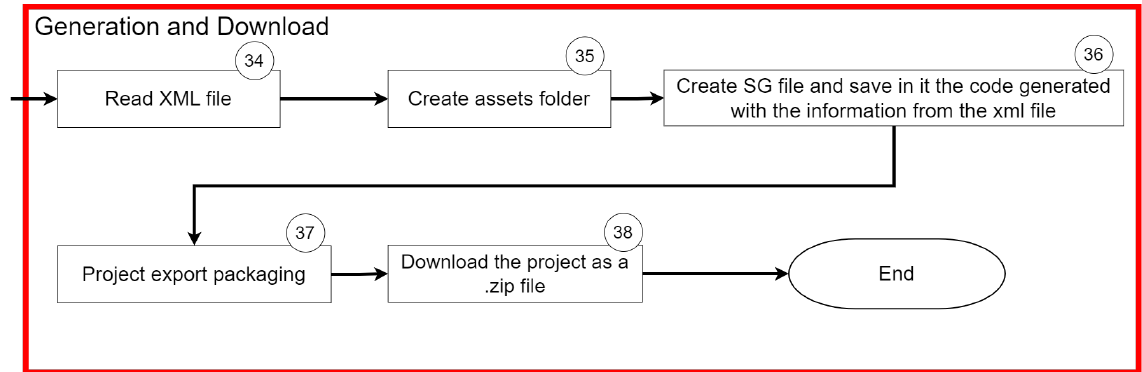
Figure 3. The flowchart’s final section is where source code is